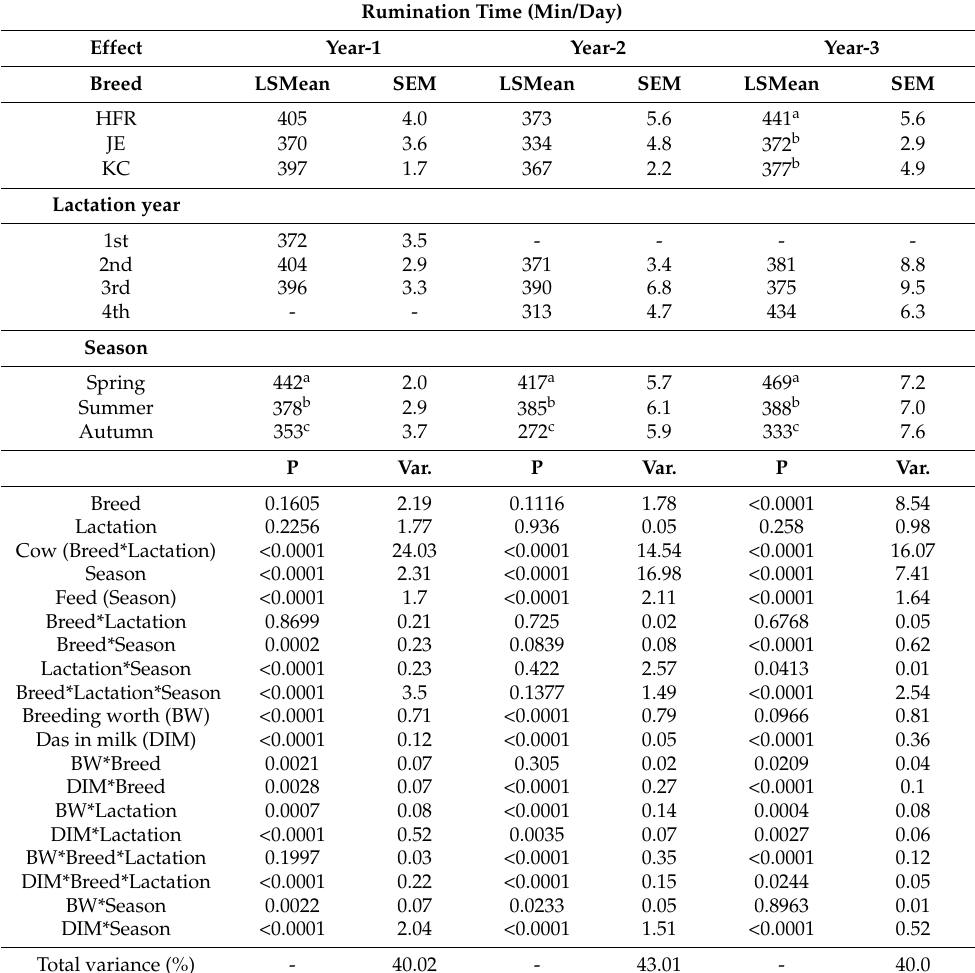
Table 3. Least square means (LSMeans) and standard errors of means (SEM) of rumination time (min/day) for the effects of breed, lactation year and season, and P values and the variance (%) explained by breed, lactation year, cow within breed and lactation year, season, feed within the season, breeding worth (BW) index, days in milk (DIM), and their interactions in three consecutive years of the stiudy period using a mixed effects model with the cow ( n = 54 ) as a random factor, and BW and DIM as continuous